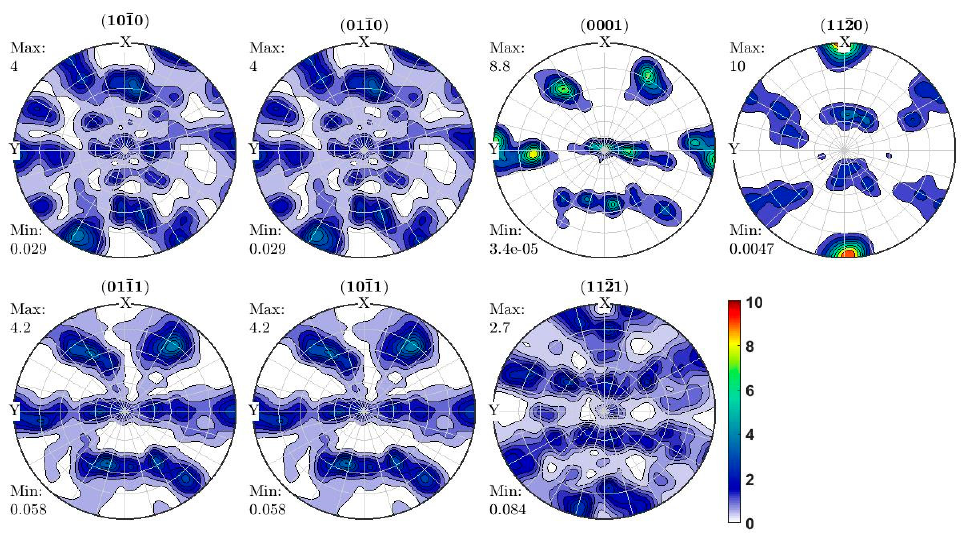
(cid:16) (cid:17) (cid:16) (cid:17) (cid:16) (cid:17) (cid:16) (cid:17) (cid:16) (cid:17) (cid:16) (cid:17) 1010 , 0110 , ( 0001 ) , 1120 , 0111 , 1011 and 1121 PFs of the α -phase for samples B.